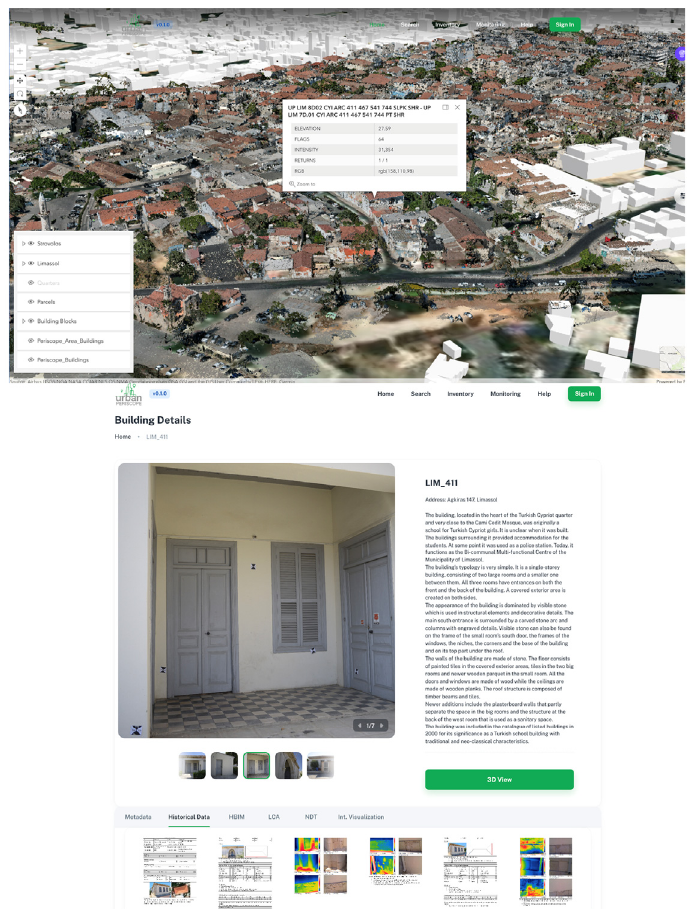
Figure 18. Data visualization of Strovolos historical core on the alpha version of the online PERIsCOPE platform.